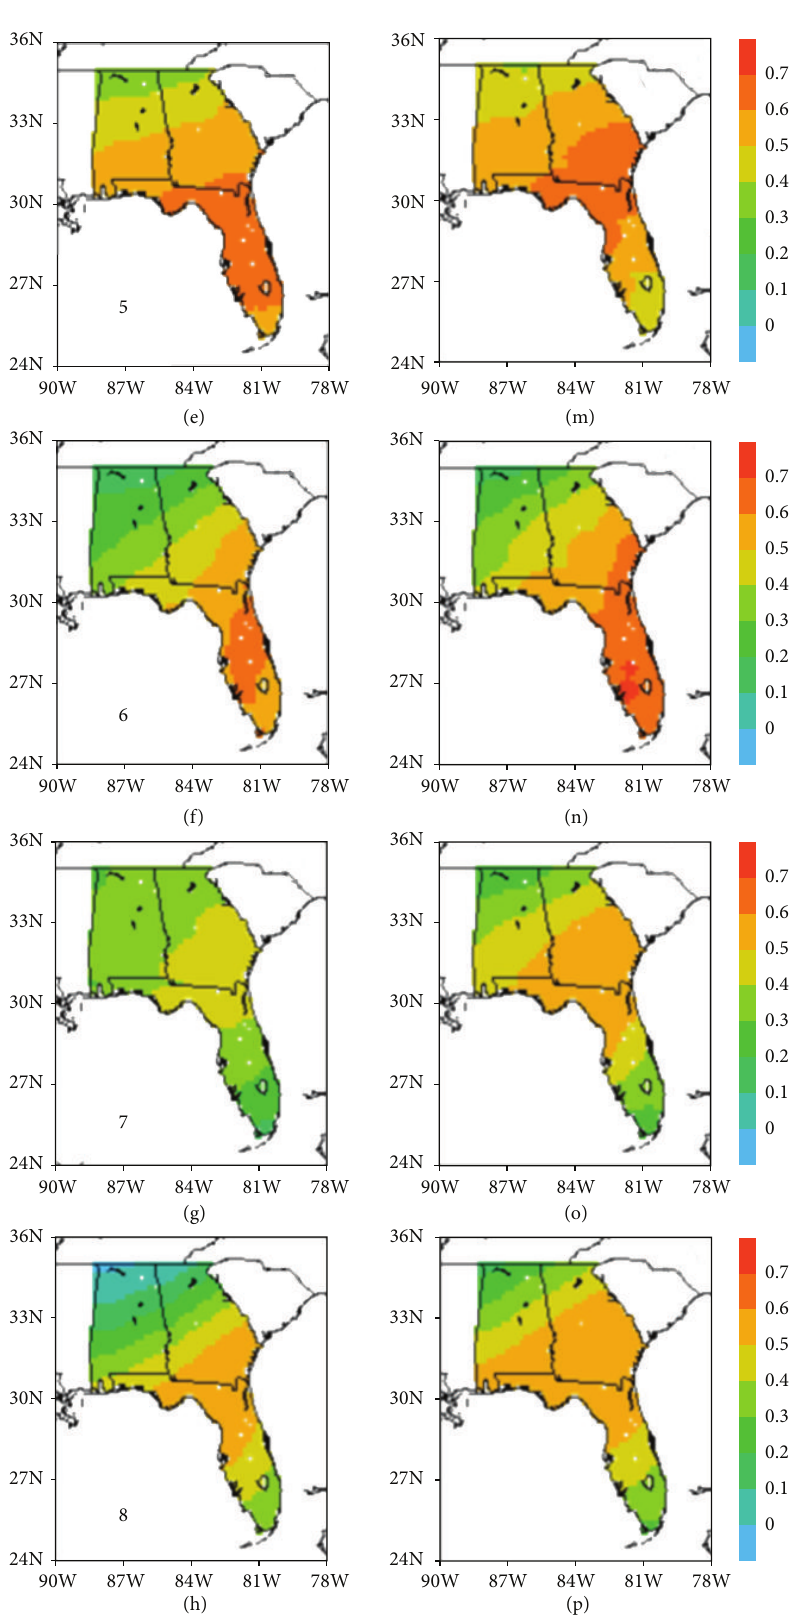
Figure 2: Temporal correlations between November Ni˜no 3 index and the DJF mean daily precipitation anomalies for historical (a–h) and RCP8.5 (i–p) experiments from CMIP5 models. Each model is identified by ID number as in Table